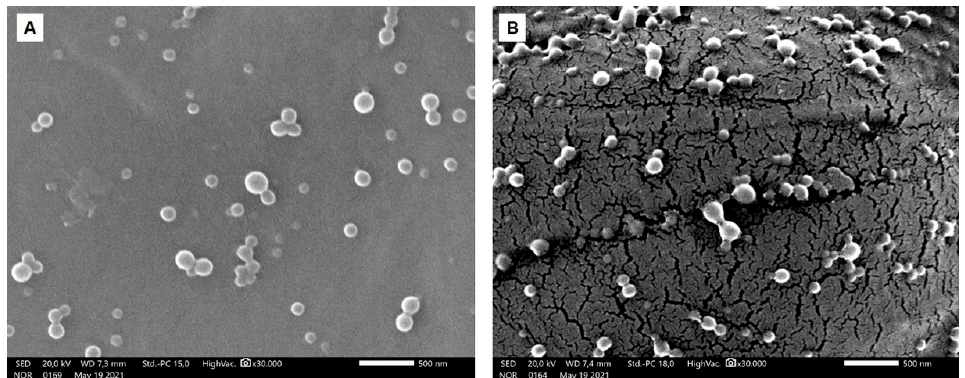
Figure 1. SEM images of NP ‐ Cb ( A ) and NP ‐ C ( B ) were acquired at 20 kV. Magnification: 30,000 times. Scale bar: 500 nm.